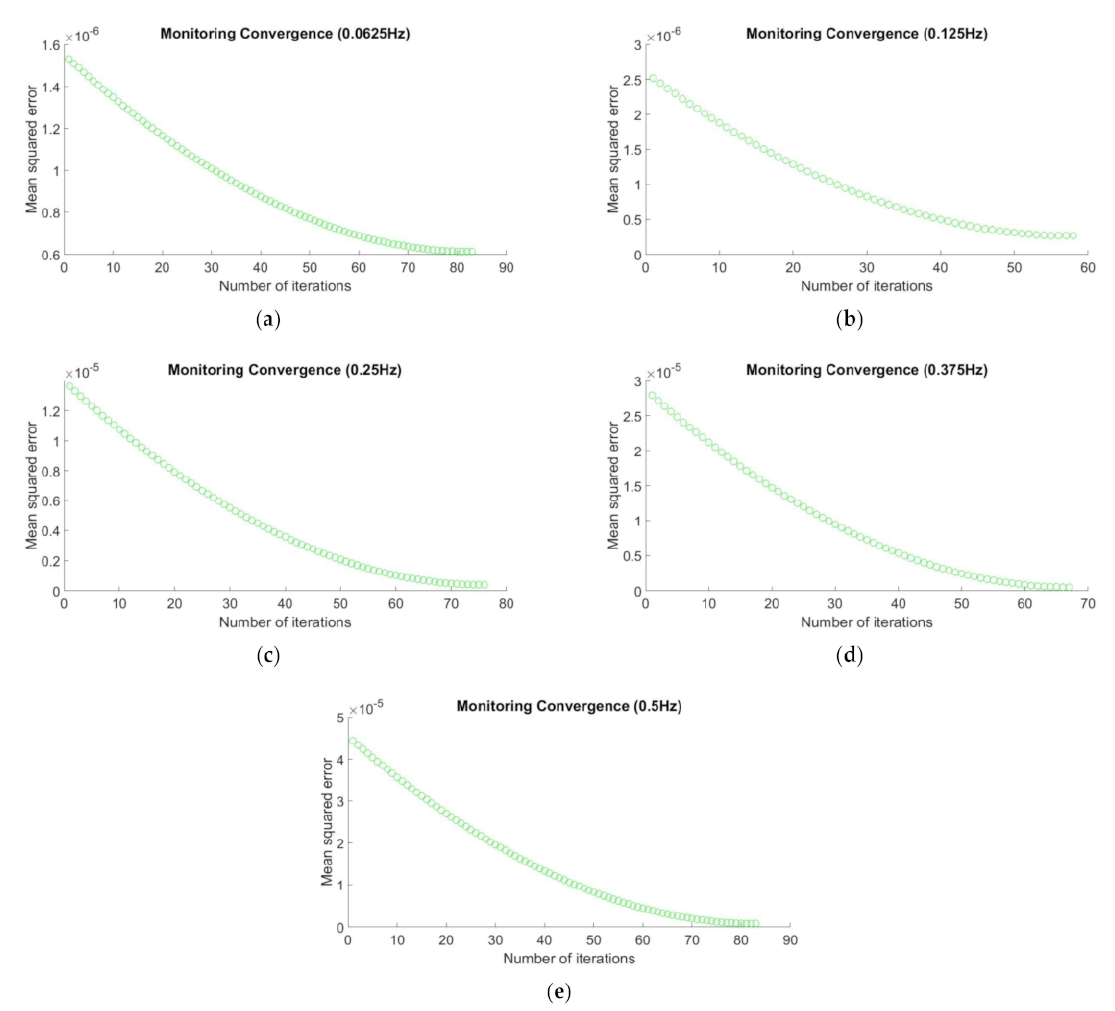
Figure 9. Mean squared error (MSE) versus number of iterations for multiple transmission frequencies (Observational dataset 1 with “unknown” resistivity of 100 Ω m): ( a ) 0.0625 Hz, ( b ) 0.125 Hz, ( c ) 0.25 Hz, ( d ) 0.375 Hz, and ( e ) 0.5